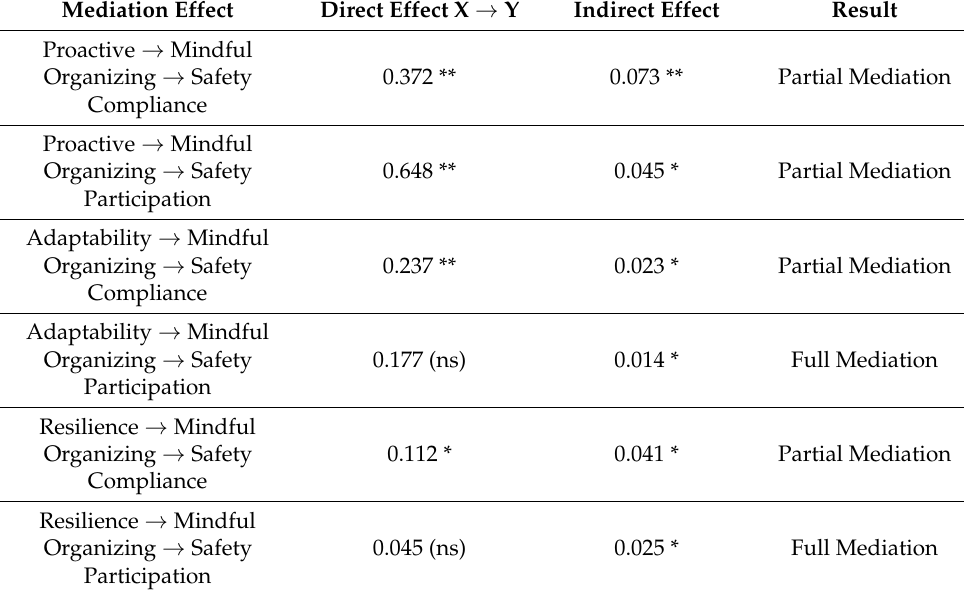
Table 5. Standard direct and indirect effects for the mediation